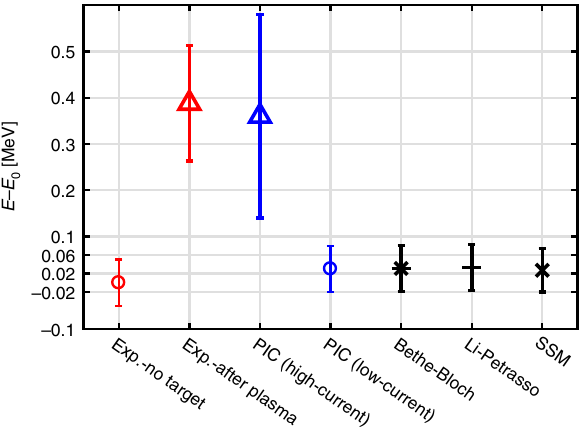
Fig. 3 Measured (exp.-after plasma), numerical (PIC), and analytical predictions (Bethe – Bloch, SSM, and Li – Petrasso) of the proton beam energy spectra downshift after passing through the dense plasma target in relative to the central energy E 0 of incident proton beam. The symbols represent the central energies and the bars represent the FWHMs of the respective spectra. For comparison, the data for the incident proton beam (no target) are shown as